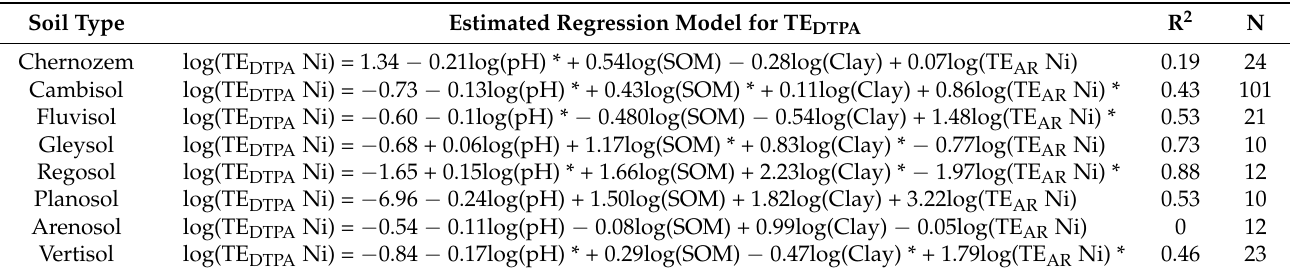
Table 8. Prediction model